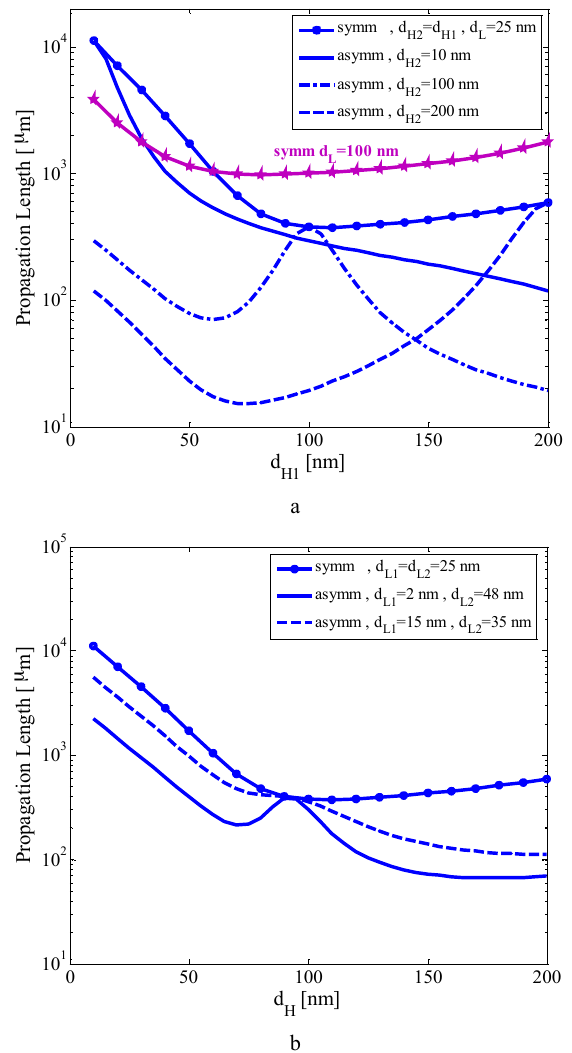
Figure 6: Propagation length of the long-range TM 1s mode of HIMI slab waveguide for: a. asymmetry of the H-Layer thicknesses at d L1 =d L2 =d L =25 nm (symmetrical cases of d L =25 and 100 nm are included for comparison), b. asymmetry of the L-Layer thicknesses for d H1 =d H2 =d H =10-200 nm. d =48 nm) and (d =15 nm , d =35 nm) are analyzed. The L2 L1 L2 symmetrical case is also shown for comparison.